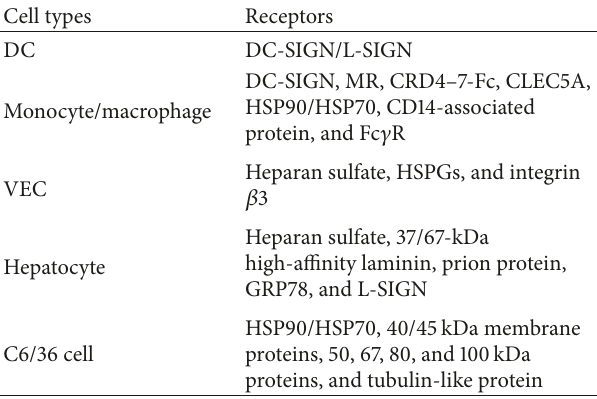
Table 1: Dengue virus receptors found in different types of